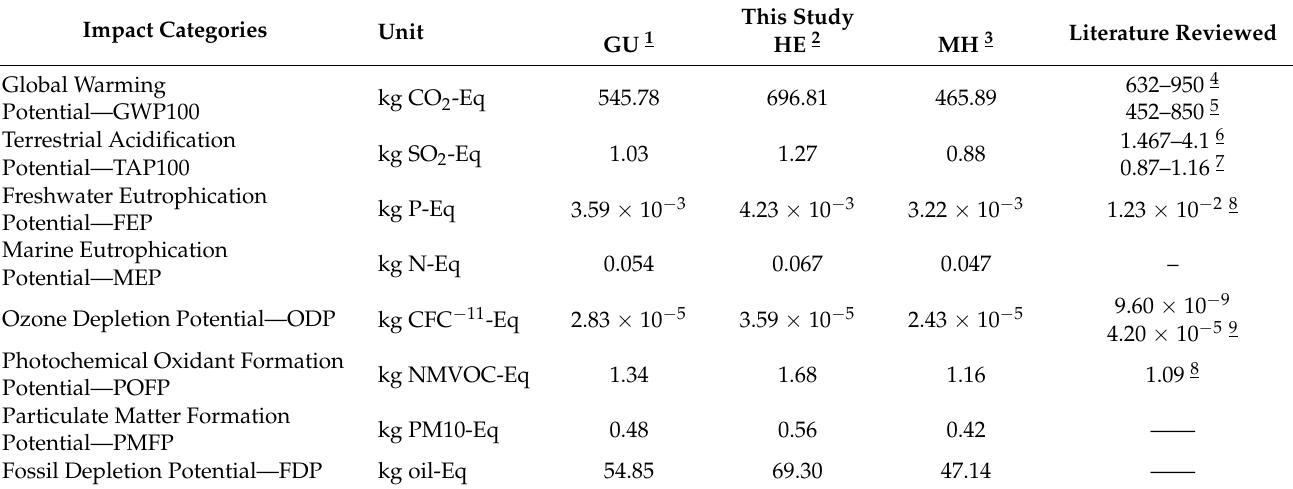
Table 2. Result of life cycle evaluation impact categories for 1 ton of composite hydraulic